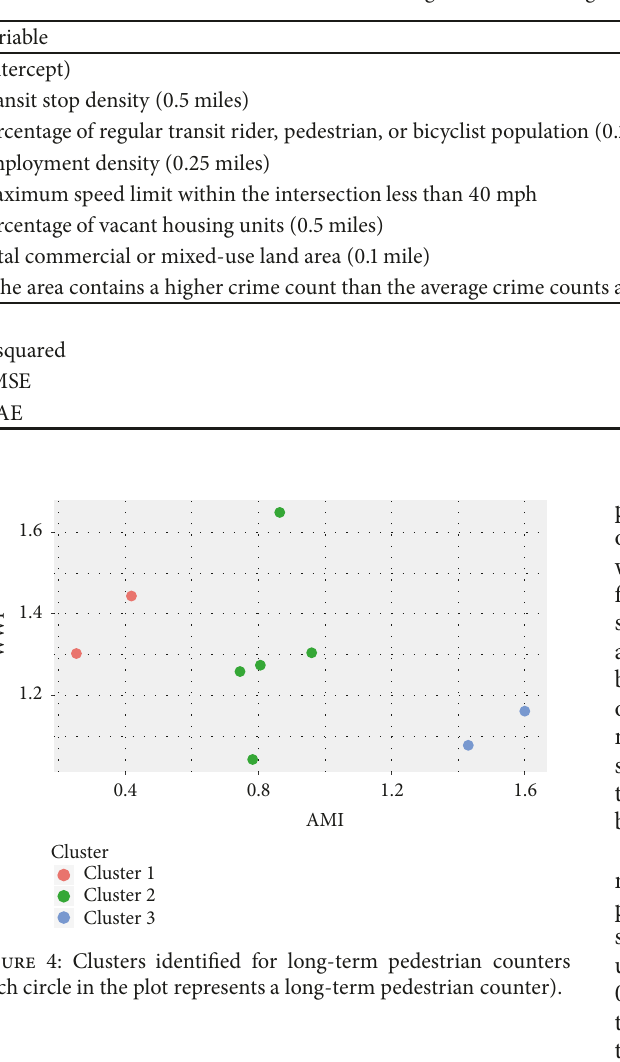
Table 1: Negative binomial regression model for pedestrians.